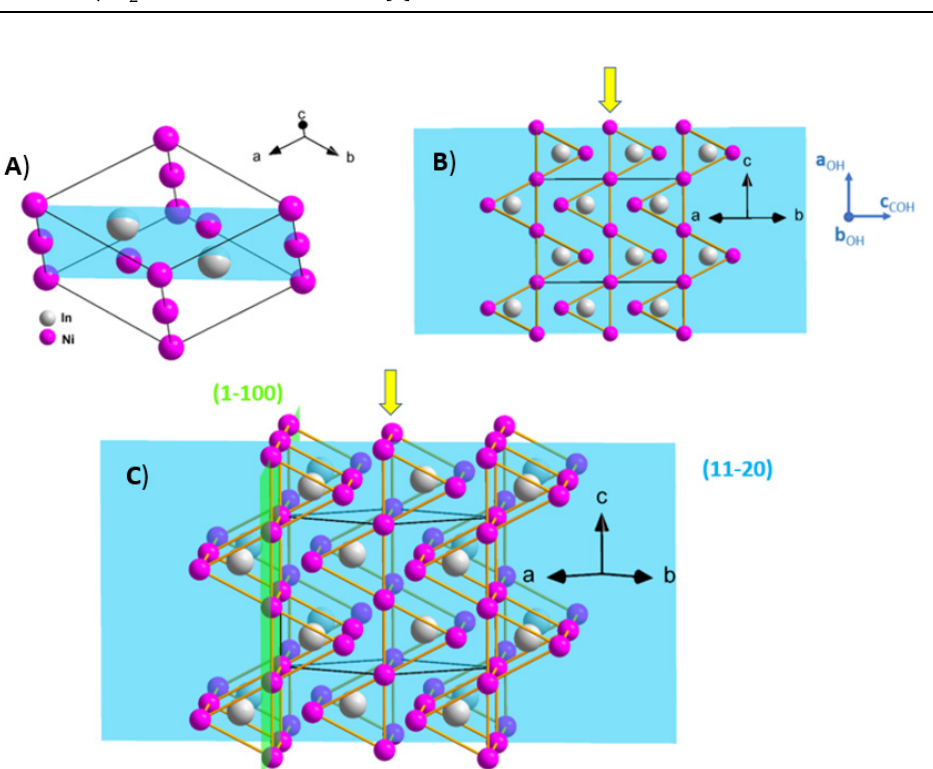
Figure 1. ( A ) Arrangement of atoms in the cell of the Ni 2 In structure. ( B ) “Walls” of trigonal prisms parallel to the (1–100) planes projected on the (11–20) planes. The relative orientation of the ortho- hexagonal reference system is also indicated. The former plane is normal, and the second one is parallel to the plane of the figure and ( C ) tilted view. The planes (11–20) and (1–100) are shown in cyan and light green color, respectively. The orange lines are delimitating the trigonal prisms. The yellow arrows indicate the middle “wall” arrangement of trigonal prisms and the reference system, with axes drawn in blue indicating the orientation of the ortho-hexagonal axes system.